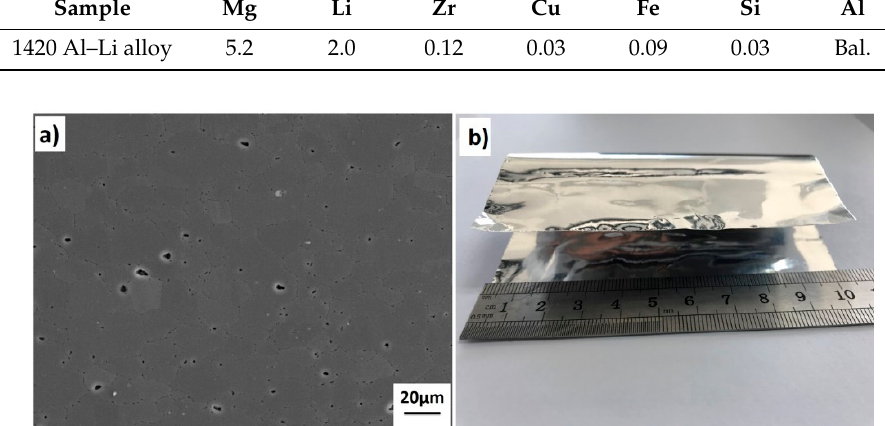
Figure 1. Microstructure of as-received 1420 Al–Li alloy plates ( a ) and image of pure Al foils ( b ). Table 1. Chemical composition of the as-received 1420 Al–Li plates (wt %)